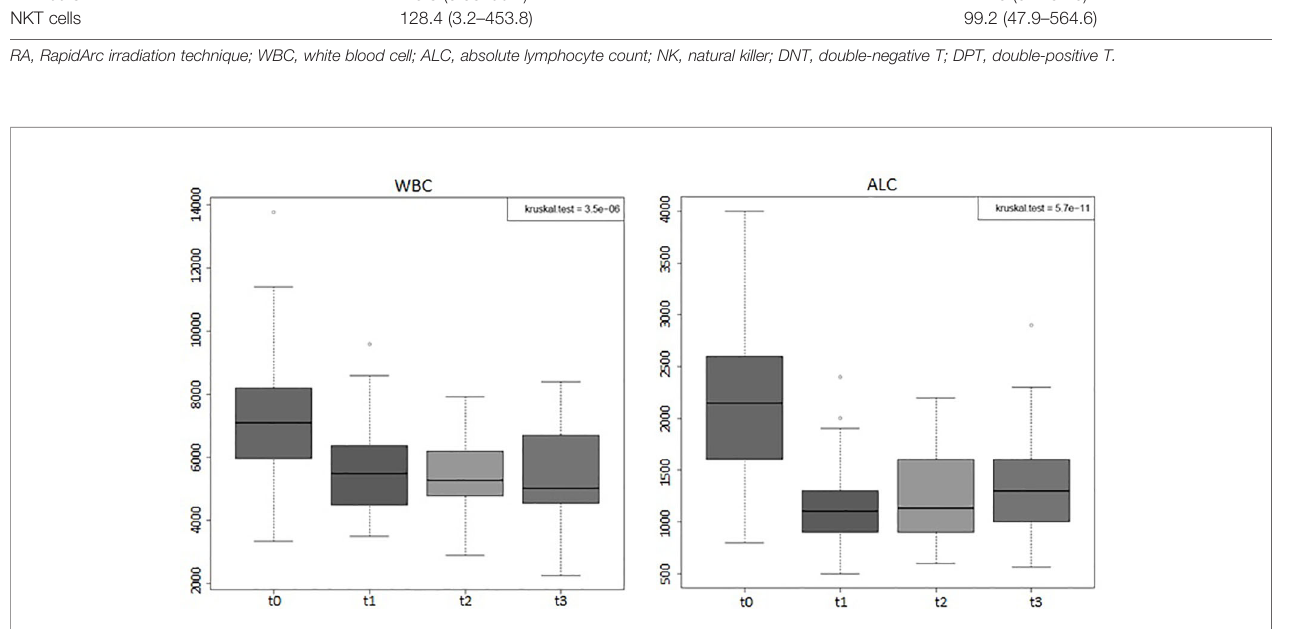
FIGURE 1 | Boxplots of the absolute white blood counts (WBCs) and absolute lymphocyte counts (ALCs) of the entire group of prostate cancer patients (44) who underwent curative RT. The data shown evidenced variations statistically signi fi cant during the four time points considered (Kruskal – Wallis test, p -value < 0.001). t0: before RT; t1: end of RT; t2: 3 months after RT; t3: 6 months after RT. All values are expressed as cells/µl.